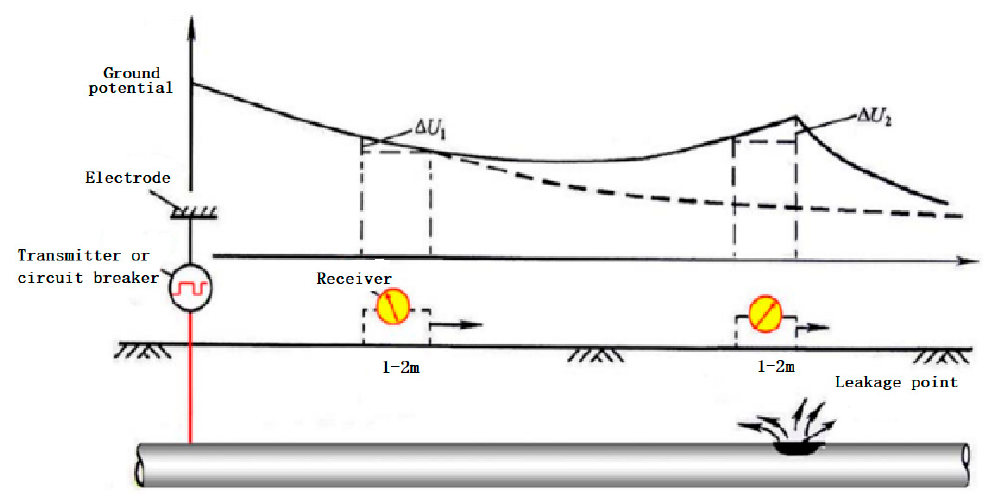
Figure 8. Principles of DCVG measurement.